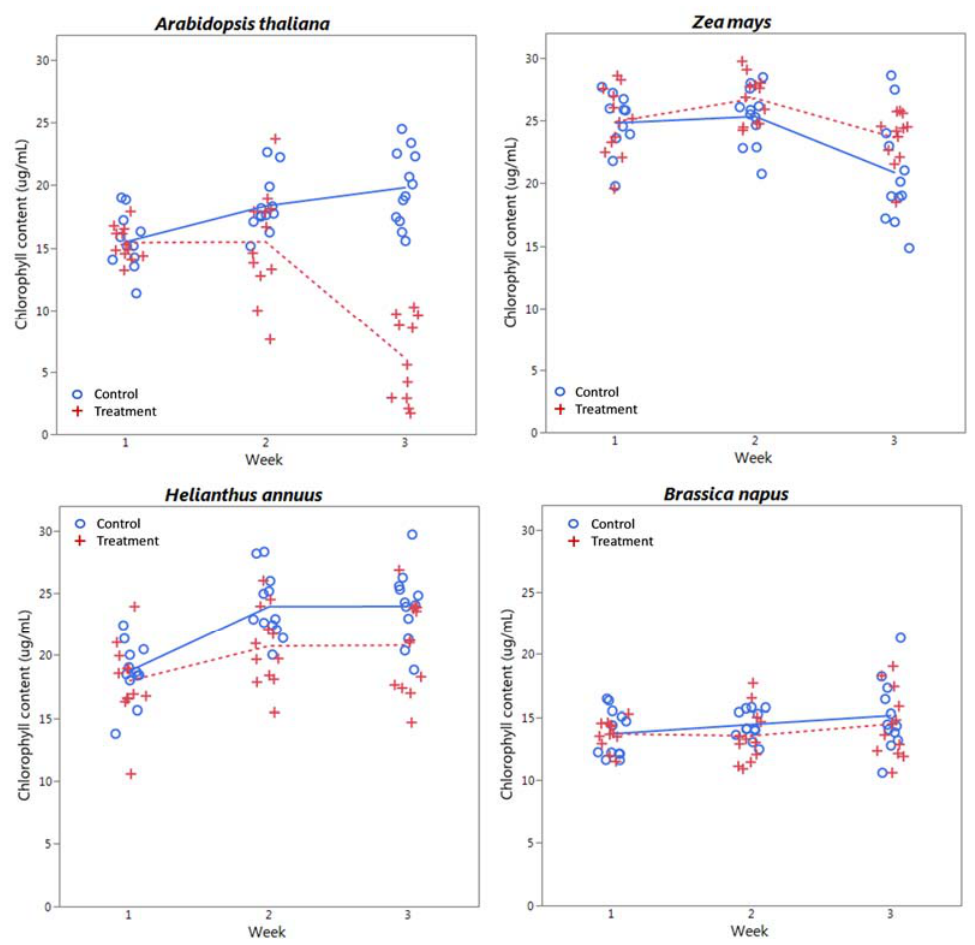
Figure 5. Chlorophyll content (Chl a + b , μ g/mL) by week and treatment level for each species considered. Lines (solid = control, dashed = treatment) indicate mean values at each week.